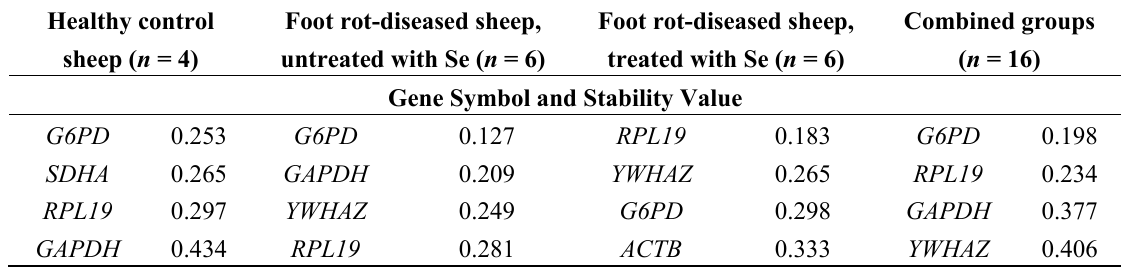
Table 4. Stability ranking of candidate reference genes in healthy control and foot rot-affected sheep, with or without selenium (Se) treatment and in combined groups, by the NormFinder algorithm (lower stability values indicate more stable gene